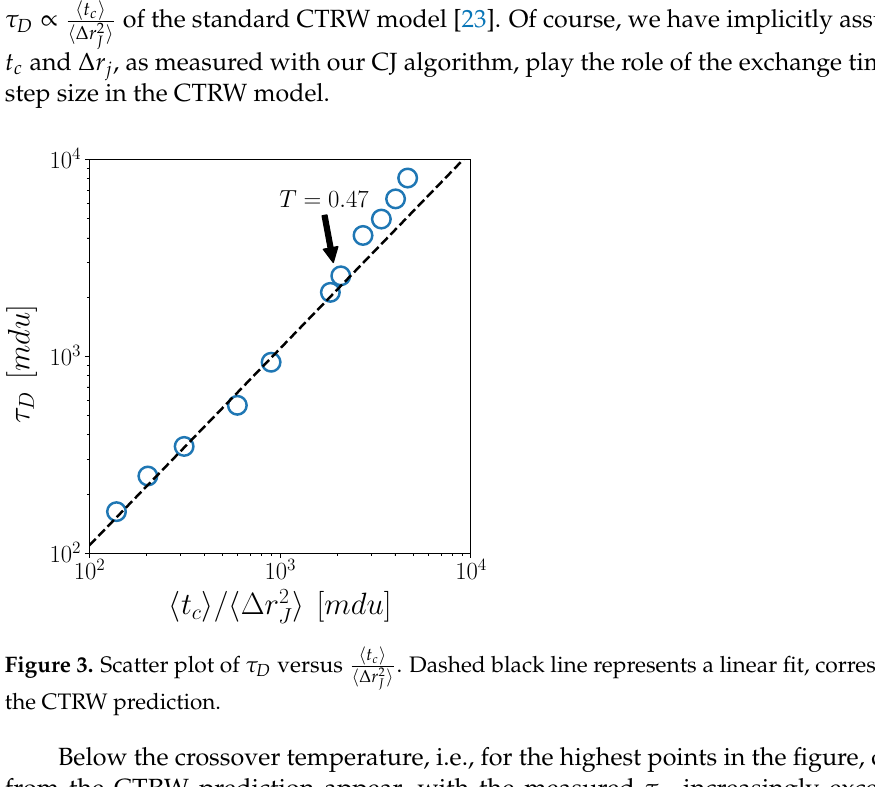
. In the high temperature regime, the trend ∆ r 2 J (cid:105) (cid:104)